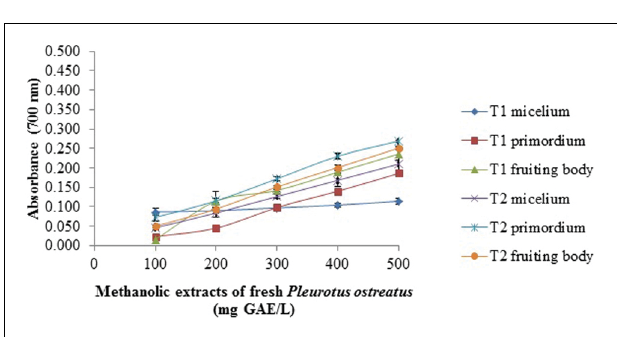
FIGURE 4 | Reducing power assay of methanolic extracts of fresh P. ostreatus . T1 and T2 as Figure 1 . Values are the average of three replicates ±